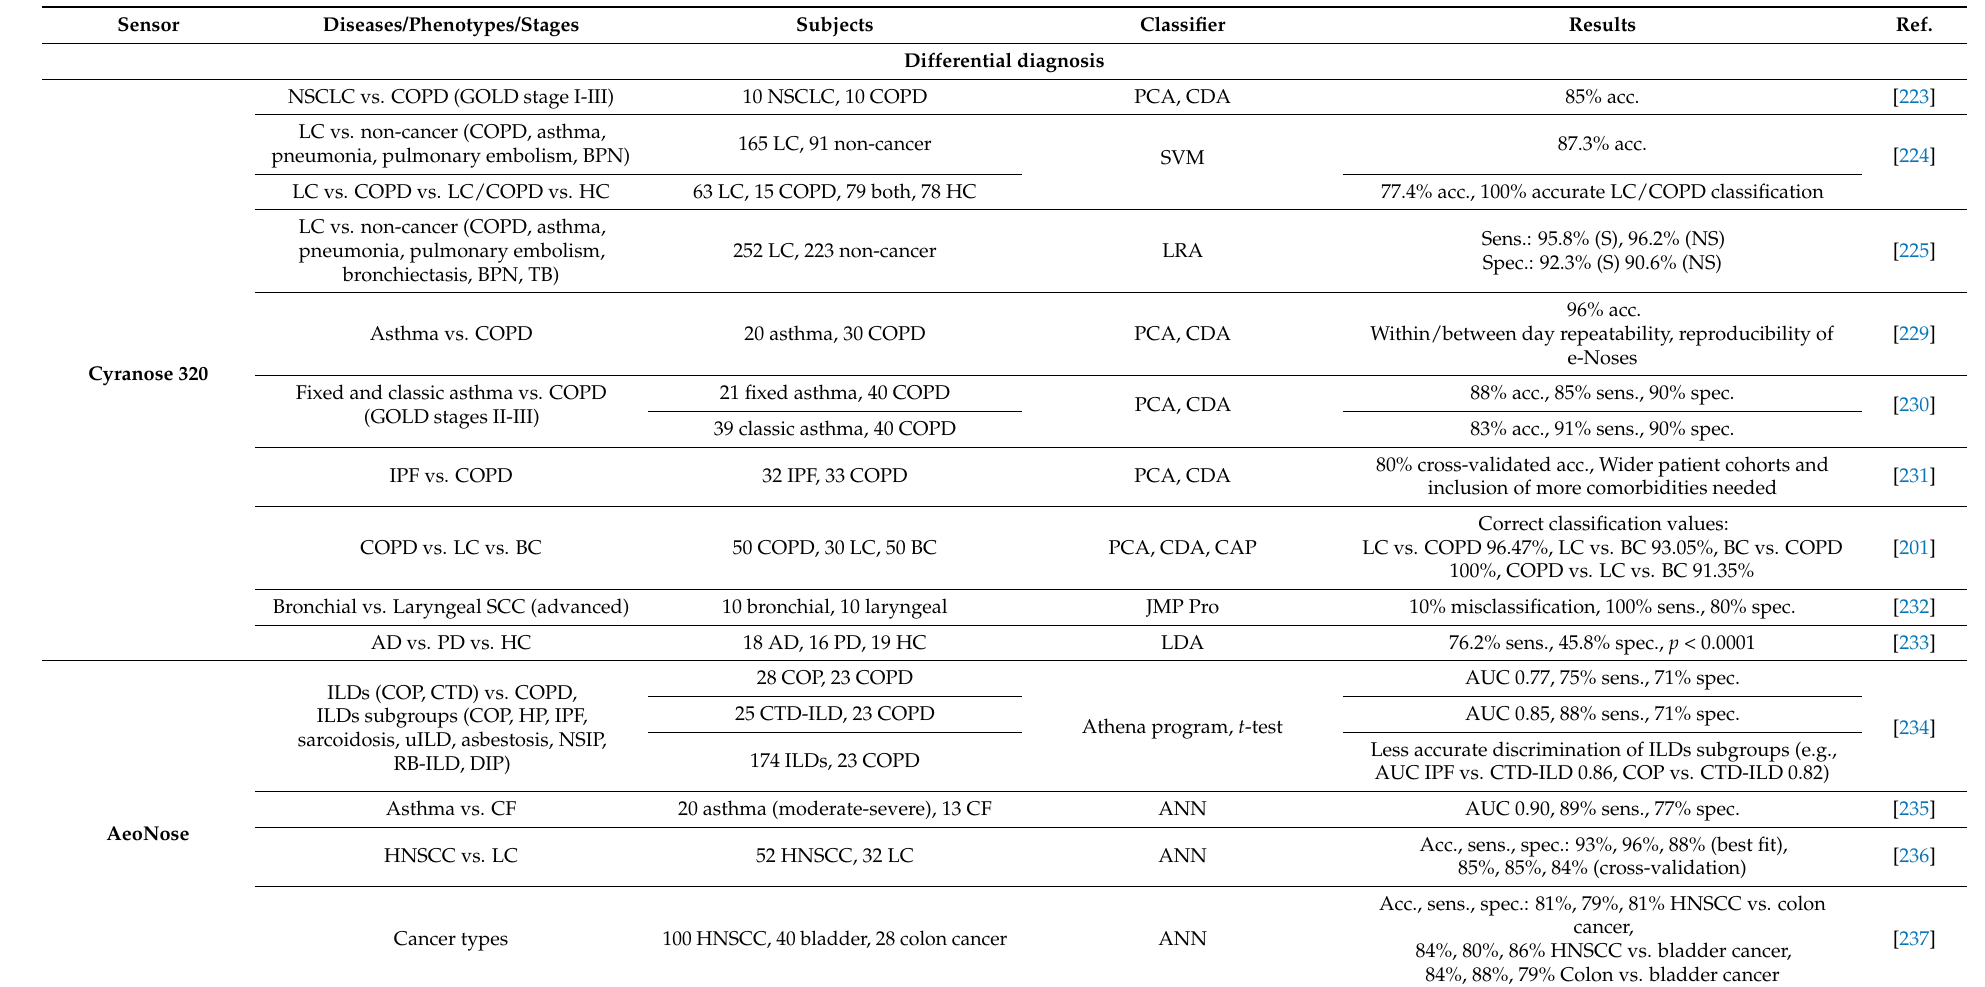
Table 4. Sensing devices used for differential diagnosis, staging, and phenotyping of different categories of